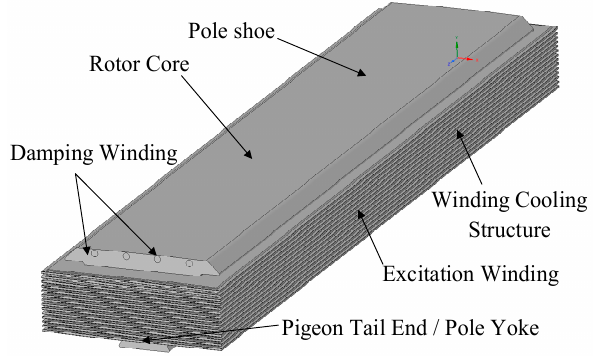
Figure 1. Calculation model of rotor magnetic pole.